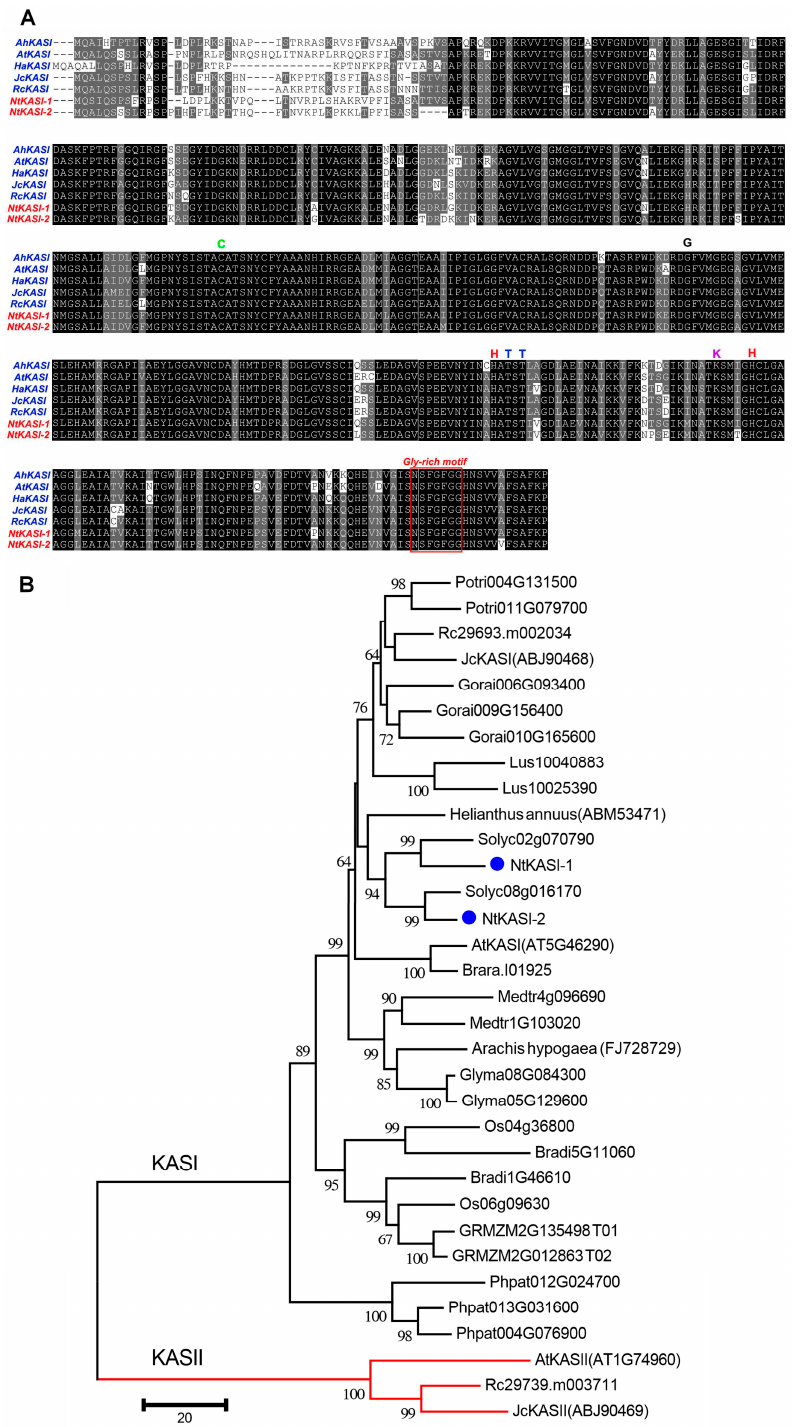
Figure 1. Multiple sequence alignment and phylogenetic analysis. ( A ) Comparison of amino acid sequences of KASI from different plants. The letters and red box represent the conserved residues and motif, respectively; ( B ) The phylogenetic tree of KAS proteins from diverse plants. The tree was generated with neighbor-joining methods and plant KASII proteins were used as the root of the KASI proteins phylogenetic tree. The blue dots represent the KASIs from tobacco. Potri, Populus trichocarpa ; Rc, Ricinus communis ; Jc, Jatropha curcas ; Gorai, Gossypium raimondii ; Lus, Linum usitatissimum ; Solyc, Solanum lycopersicum ; Nt, Nicotiana tabacum ; At, Arabidopsis thaliana ; Brara, Brassica rapa ; Medtr, Medicago truncatula ; Glyma, Glycine max ; Os, Oryza sativa ; Bradi, Brachypodium sylvaticum ; GRMZM, Zea may ; Phpat, Physcomitrella patents.